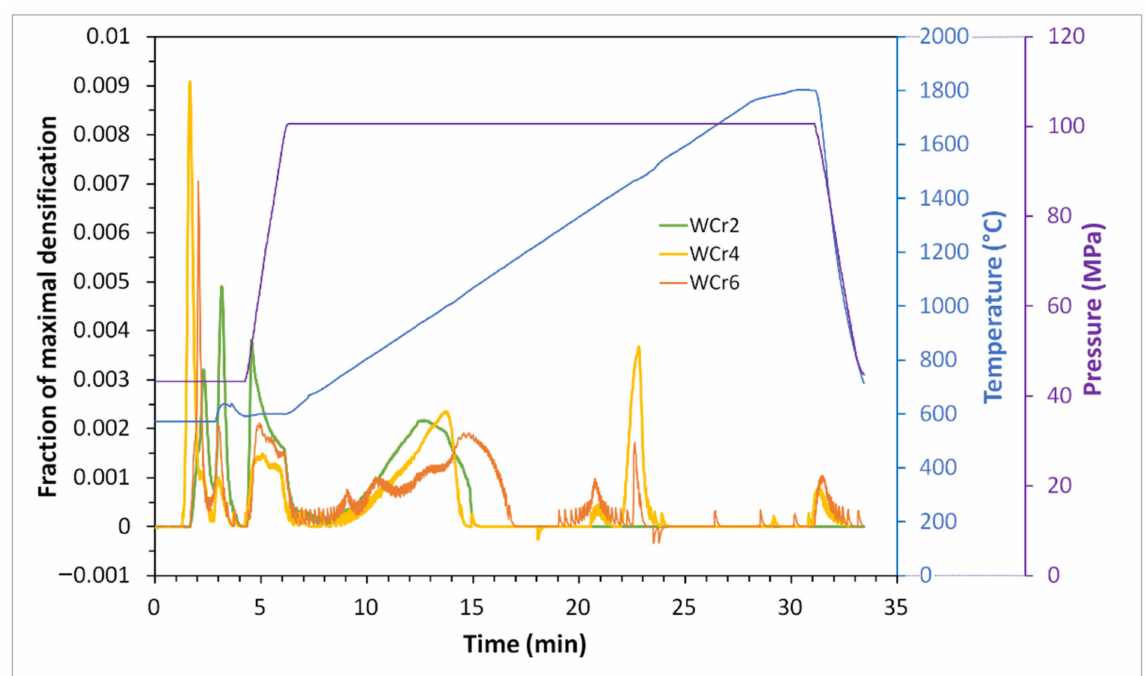
Figure 4. Spark plasma sintering (SPS) cycle (1800 ◦ C—1 (cid:48) ). Purple: pressure; blue: temperature; and green, yellow and orange: kinetics of densification as a fraction of total densification (integral of each curve is equal to